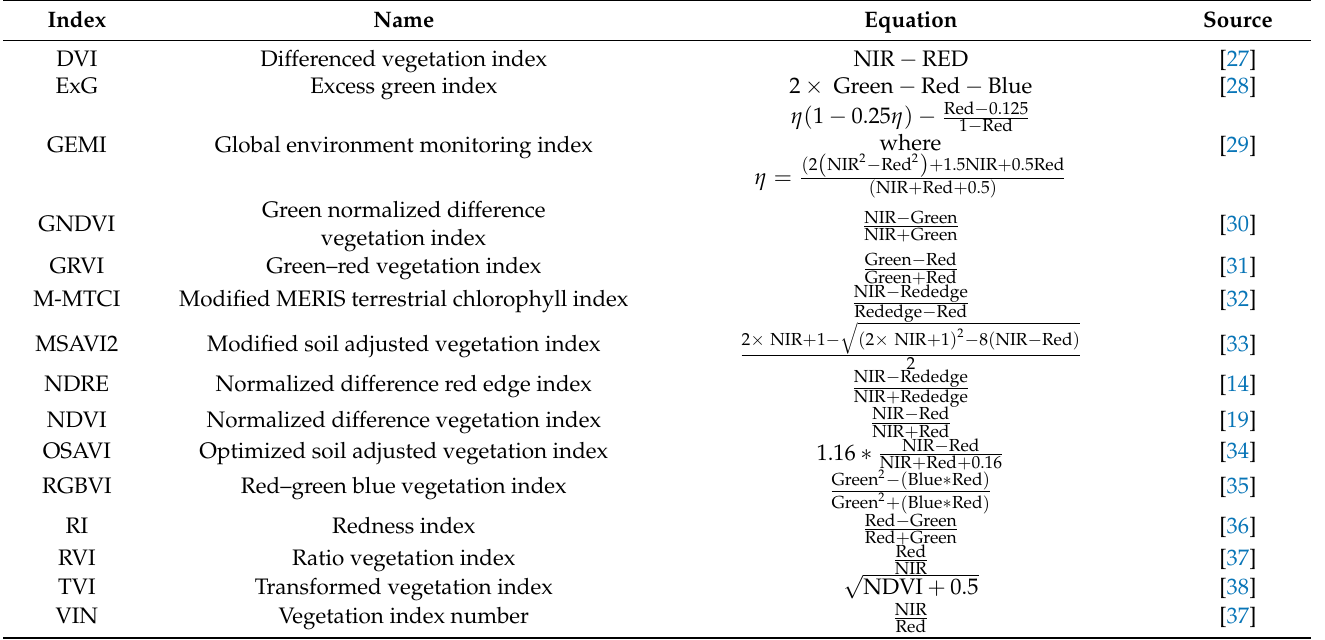
Table 2. Vegetation indices and their equations that were used in this study. M-MTCI index was modified from the original MTCI index to fit the spectral bands of the used camera. The wavelengths for the five spectral bands: green (560 nm), blue (475 nm), red (668 nm), Rededge (717 nm), and near-infrared (NIR, 840